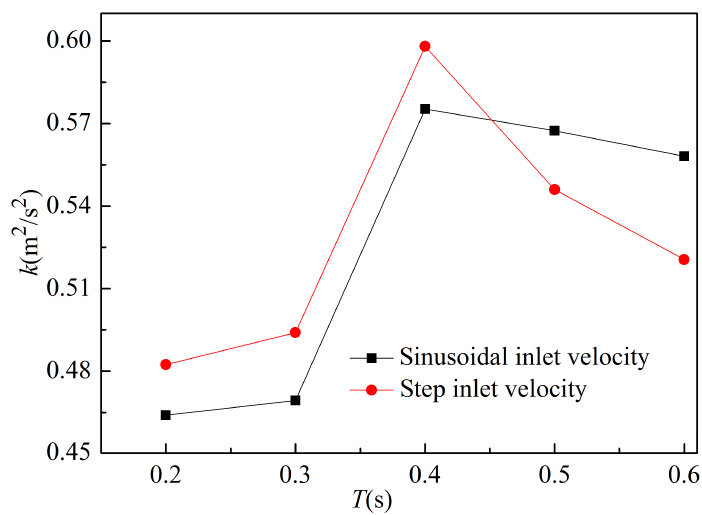
Figure 16. Effects of period on the mean k of the impingement region during one period by CFD at u m = 1.25 m/s, A = 0.25 m/s, L/D = 4 and ∆ ϕ = T /2.